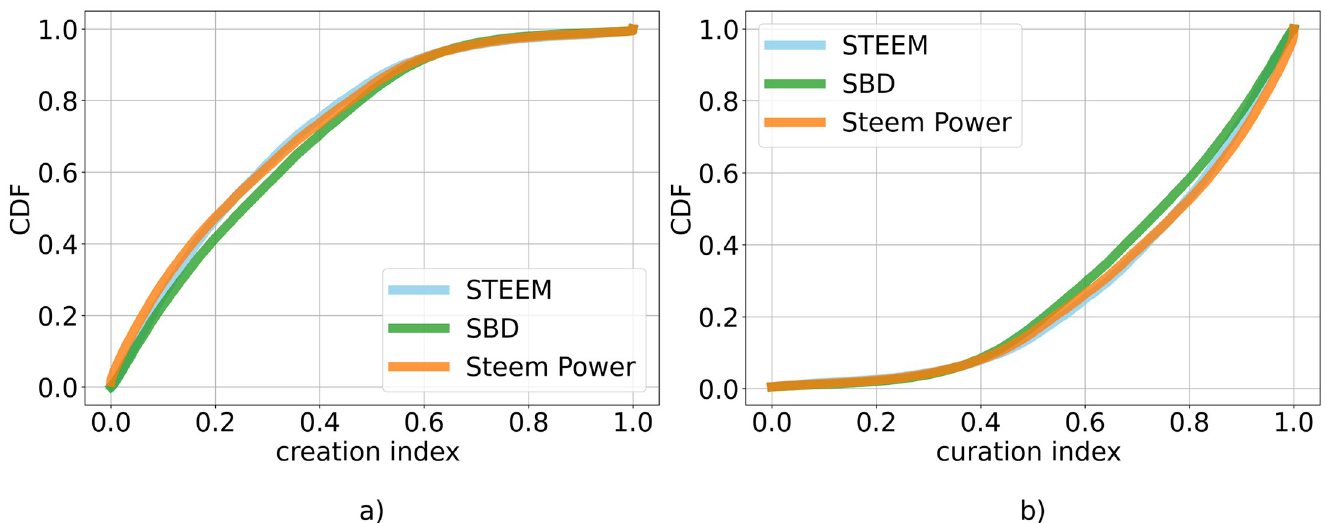
Fig 8. Curation index distribution. Cumulative Distribution Function of the curation _ index , for each of the three currencies. On the x-axis: the creation index, which measures how much a user relies more on curation operations. On y-axis: Cumulative Distribution Function—CDF.